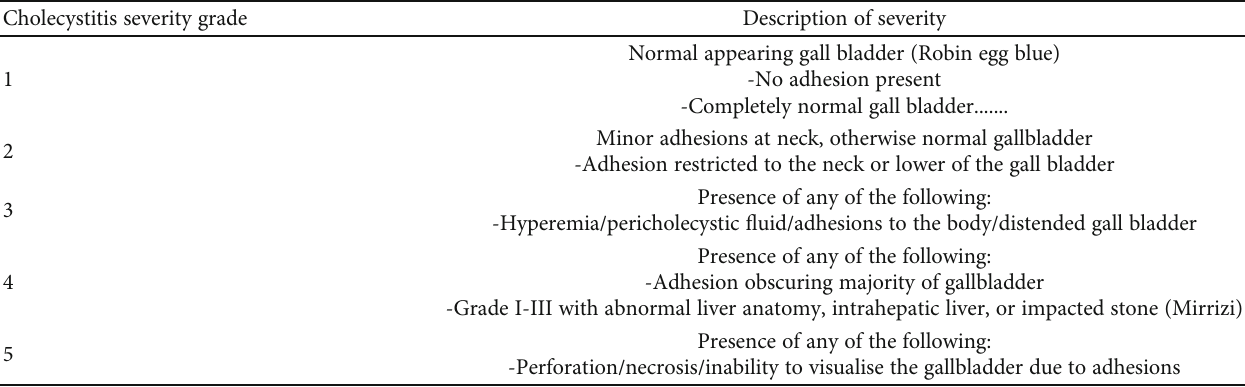
Table 1: Parkland grading scale for cholecystitis